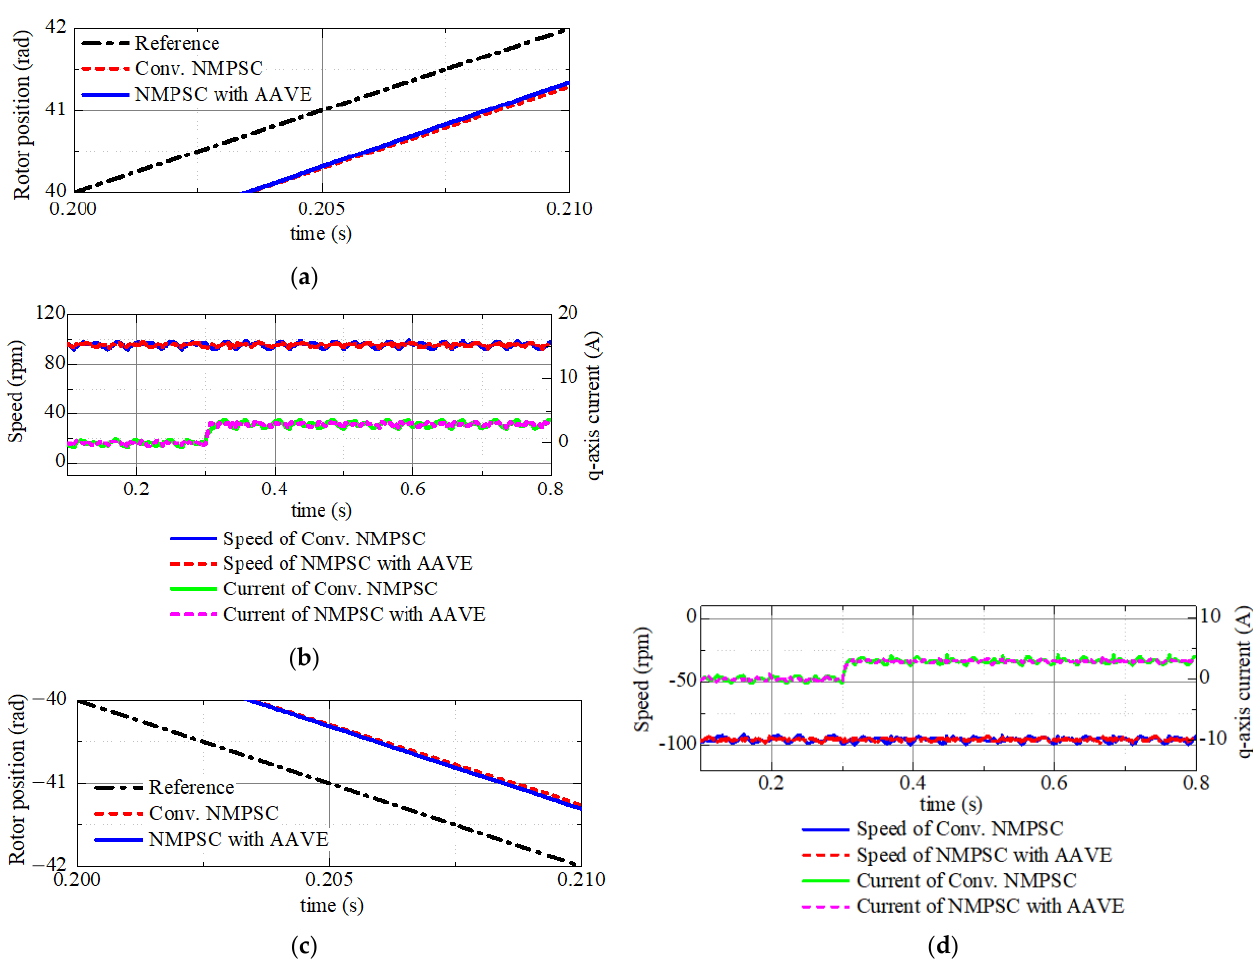
Figure 7. Simulation results of ramp references of the proposed NMPSC with AAVE method and conventional NMPSC. ( a ) Rotor positions with a positive slope; ( b ) Speed and torque current ( q -axis) with a positive slope; ( c ) Rotor position with a negative slope; ( d ) Speed and torque current ( q -axis) with a negative slope. A 3 N∙m load torque is added at 0.3 s, the torque currents ( q -axis) are increased to